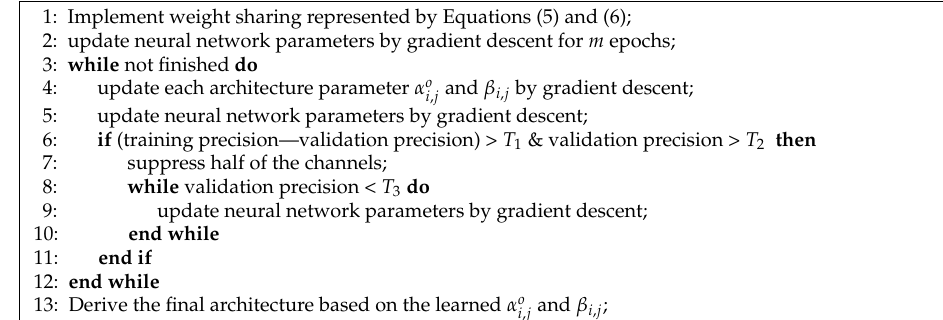
Figure 8. The algorithm steps of